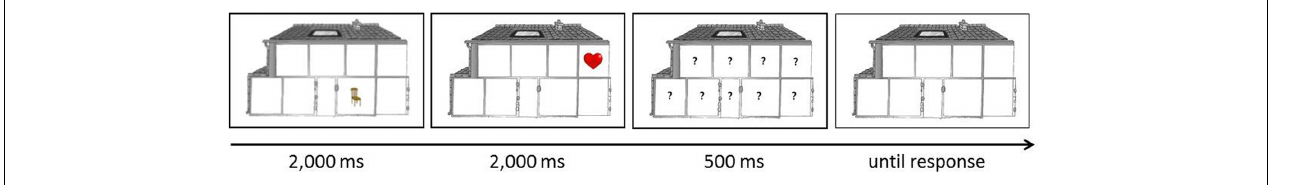
FIGURE 2 | Example of a trial ( N = 2 ) taken from the short-term feature-binding task adapted from Picard et al. (2012).